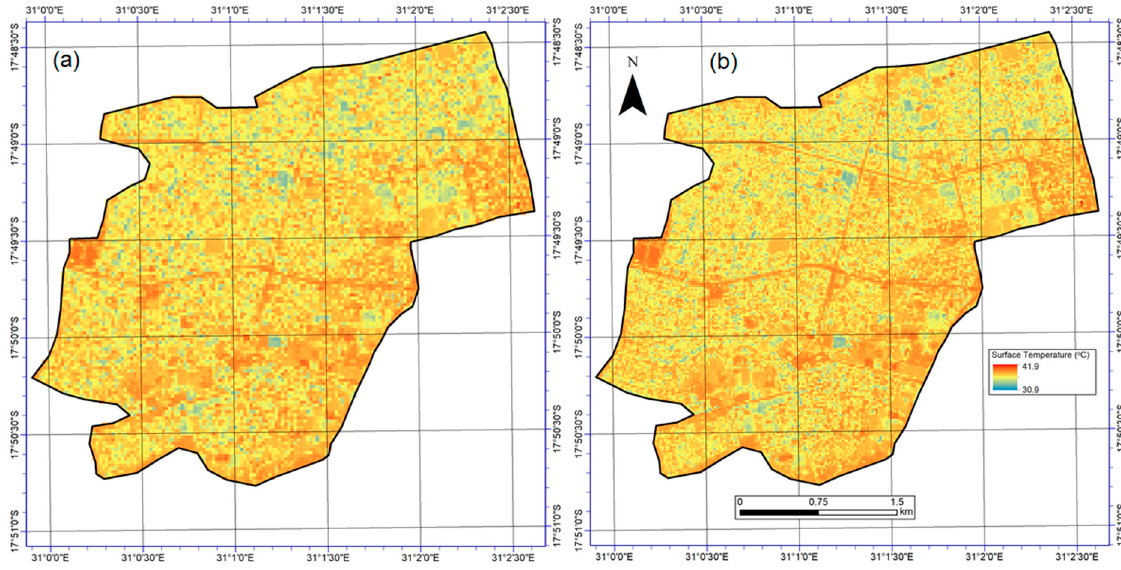
Figure 4. Spatial structure of ( a ) LST derived from Landsat thermal data at 30 - m resolution ( b ) LST sharpened to 10 - m resolution.